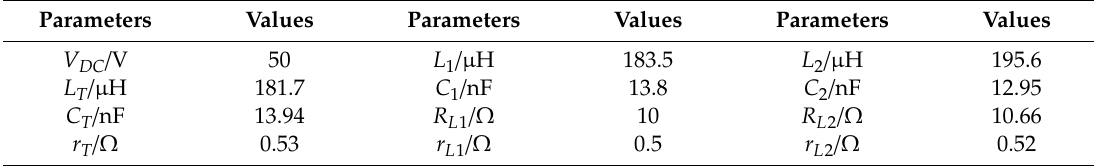
Figure 9. Simulation circuit of PT-WPT system with two loads. Table 2. Parameters of the dual-load PT-WPT system.